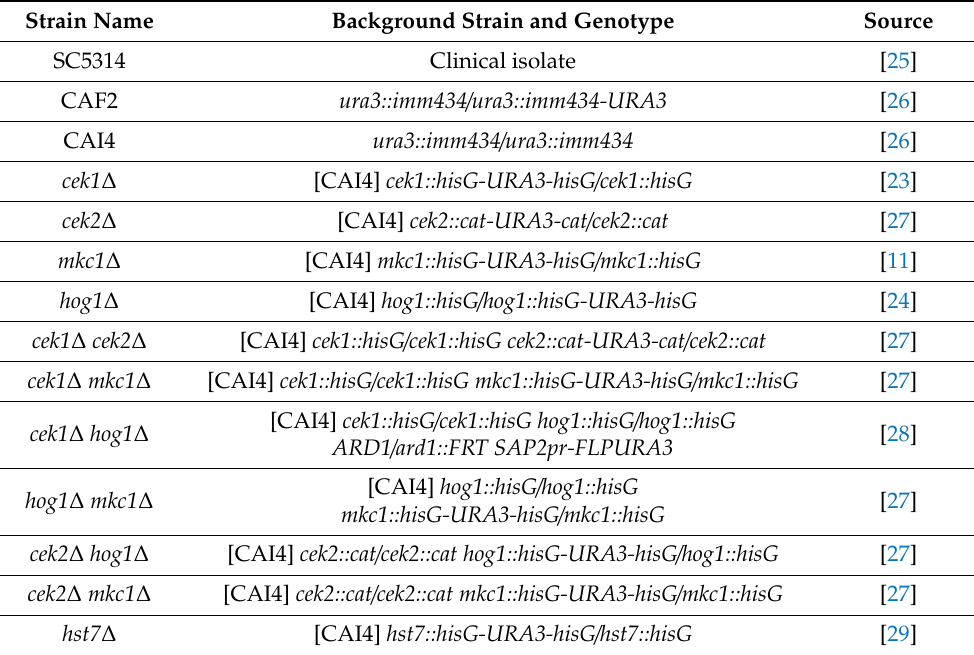
Table 1. Strains of C. albicans used in this